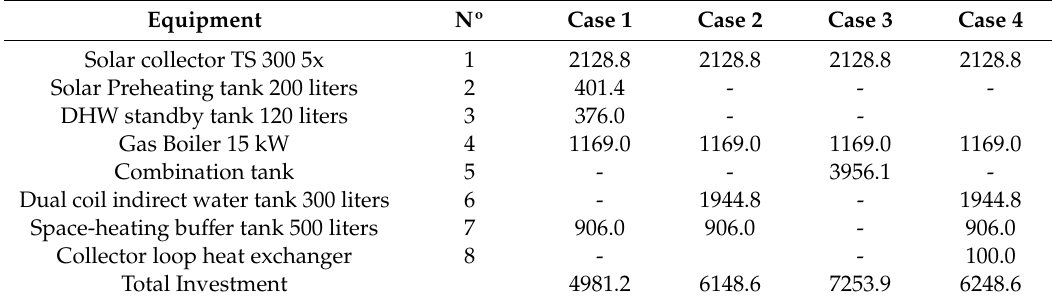
Table 4. Equipment investment for alternatives.